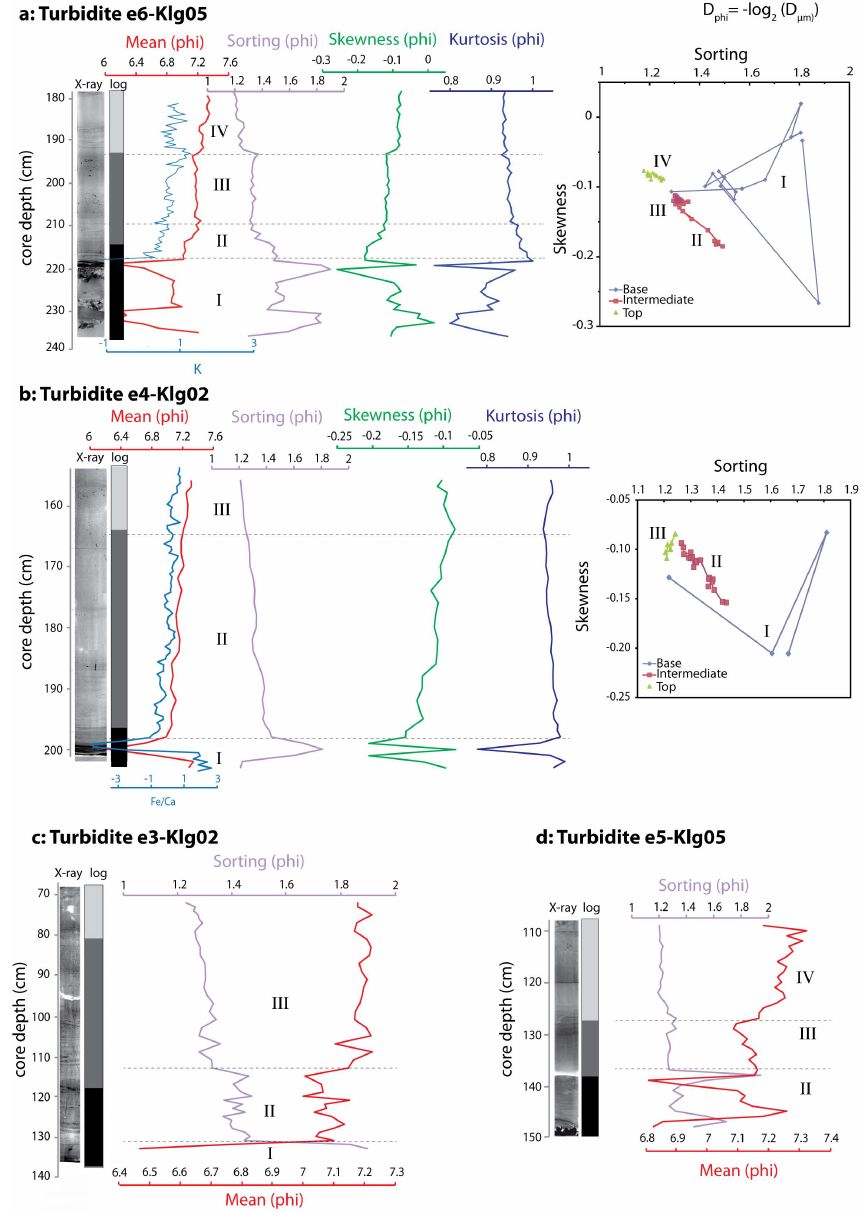
Fig. 3. Characteristics of the thickest turbidites in Klg02 and Klg05 cores by using X-ray, log, grain size and geochemical